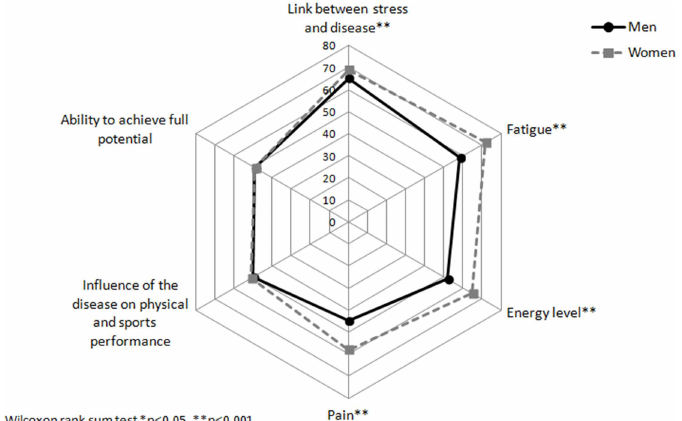
Fig 1. Median for individual concerns related to symptoms according to